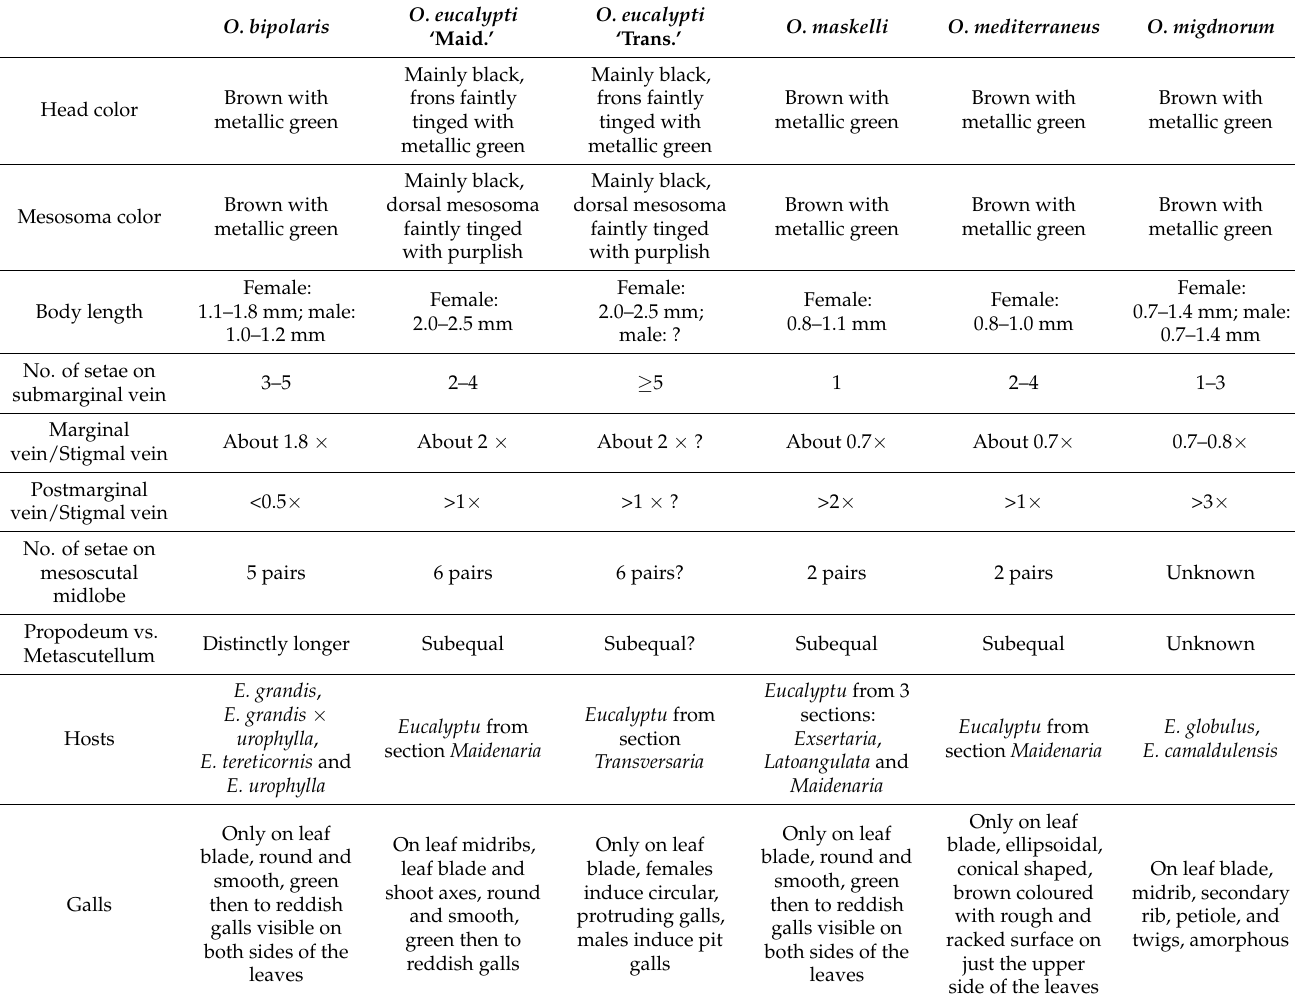
Table 3. Comparison of Ophelimus bipolaris with other known Ophelimus species.